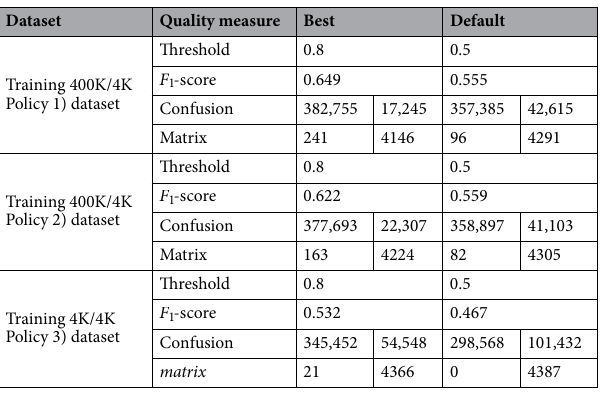
Table 6. Performance of synthetic traffic when generators use custom activation functions in the output. Results on testing using the best models on training.